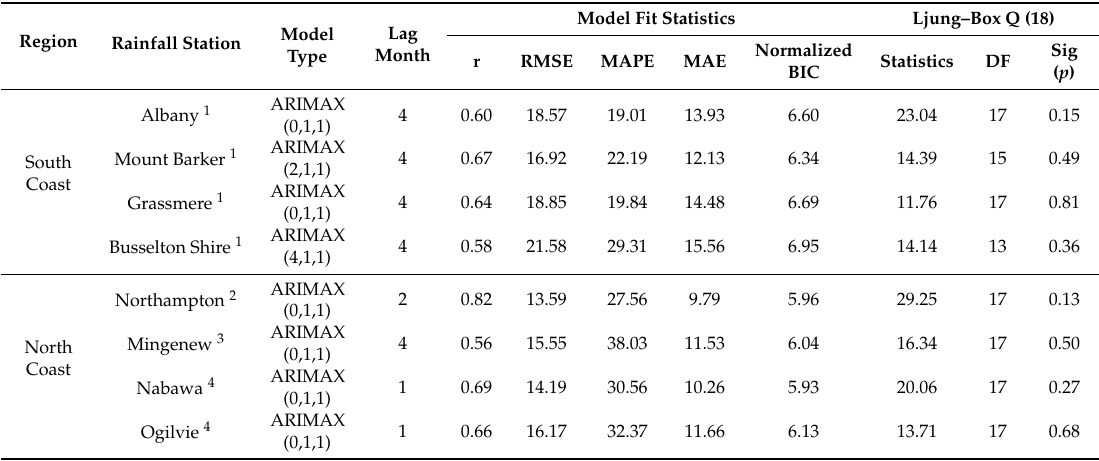
Table 6. Model description of the selected ARIMAX models in the calibration period.